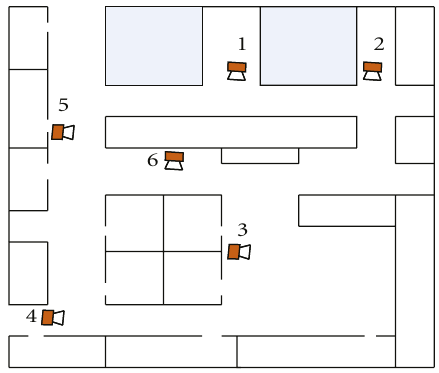
Figure 13: Experiment setup. Building plan where the observations were